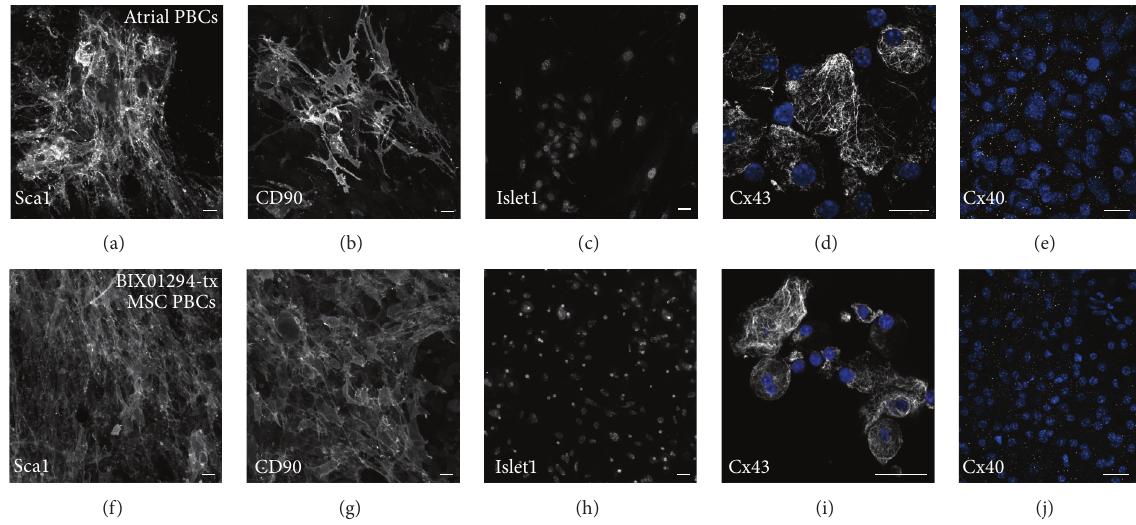
Figure 5: Shared expression of progenitor markers in atrial and bone marrow-derived PBCs. PBCs were collected from either (a–e) atrial cultures or (f–j) BIX01294 plus CCM-treated MSCs and immunostained following (a–c; e–h, i) their attachment on Cell-Tak coated chamber slides or (d, i) being cytospun onto glass slides. Subsequent immunofluorescent labeling of the cells (shown in gray) was used to detect the expression of (a, f) Sca-1 (b, g) CD90 (c, h) Isl-1, (d, i) Cx43, and (e, j) Cx40. Cultures were counterstained with DAPI to visualize nuclei (blue). Scale bar = 25 𝜇